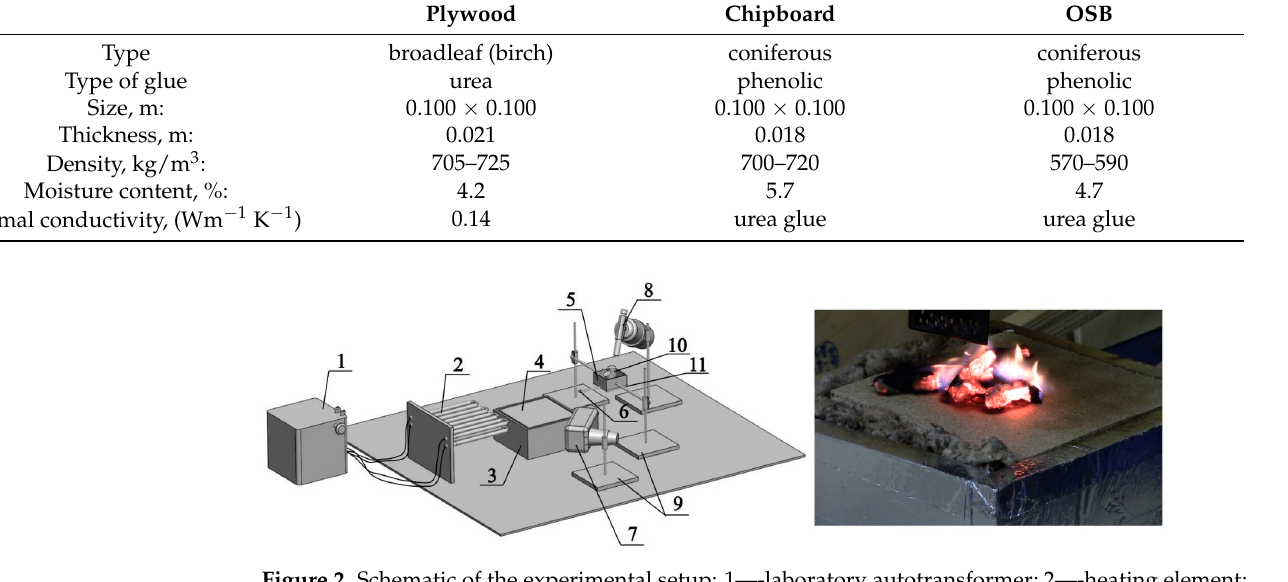
Figure 3. Photo of the sample before the experiment.